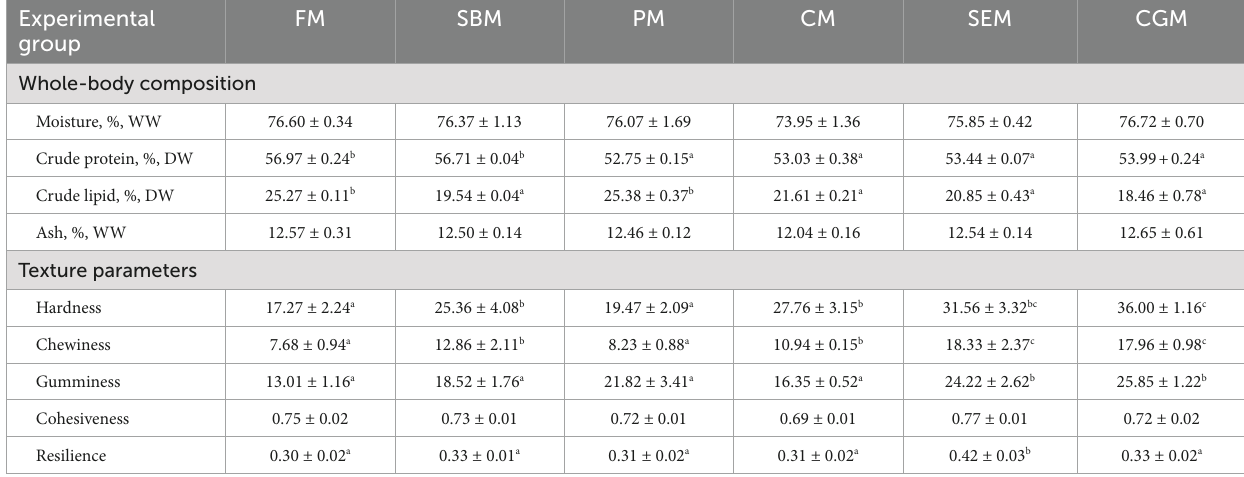
Values are means ± SEM of 3 replications; Values within a row without a common superscript letter (a, b) are different (c indicates a higher value). WW and DW are the abbreviation of wet weight basis and dry weight